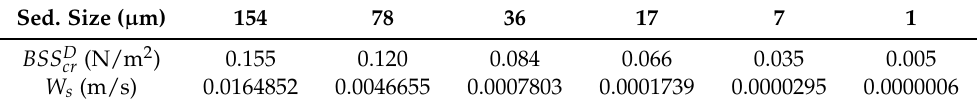
Table 2. Modelled bottom shear stresses for deposition and settling velocities. Sed. Size ( µ